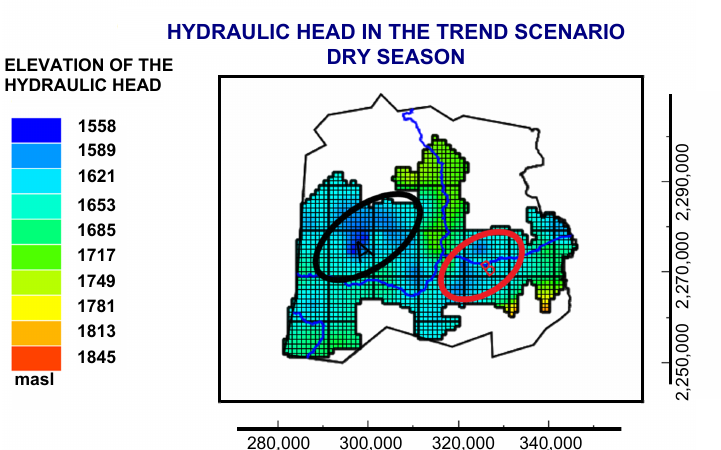
Figure 16. Elevation of the hydraulic head of the year 2030 through the trend scenario in the Figura 3.1: Elevaci´on de la carga hidr´aulica del a˜no 2030 a trav´es del escenario Tendencial en la dry season. Temporada de Secas.